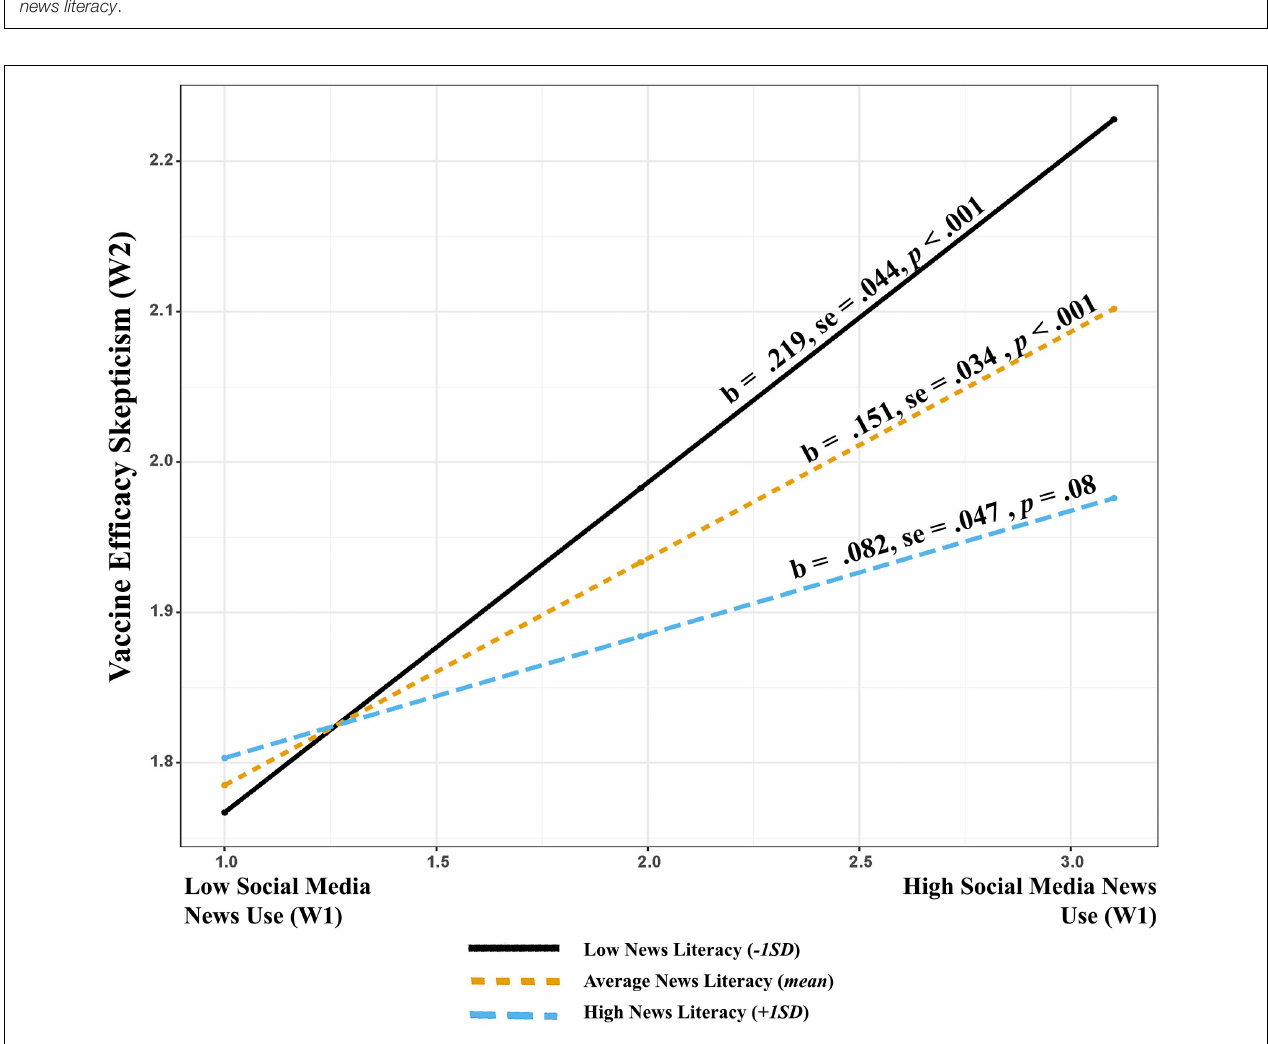
FIGURE 3 | Conditional effect of social media news use (w1) at different values of news literacy (w1) predicting skepticism (w2).